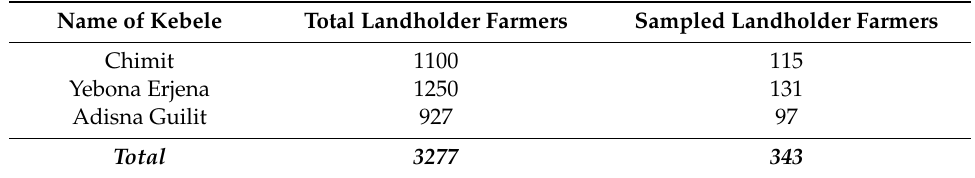
Table 2. Number of total landholder farmers and sample landholders of the study area. Name of